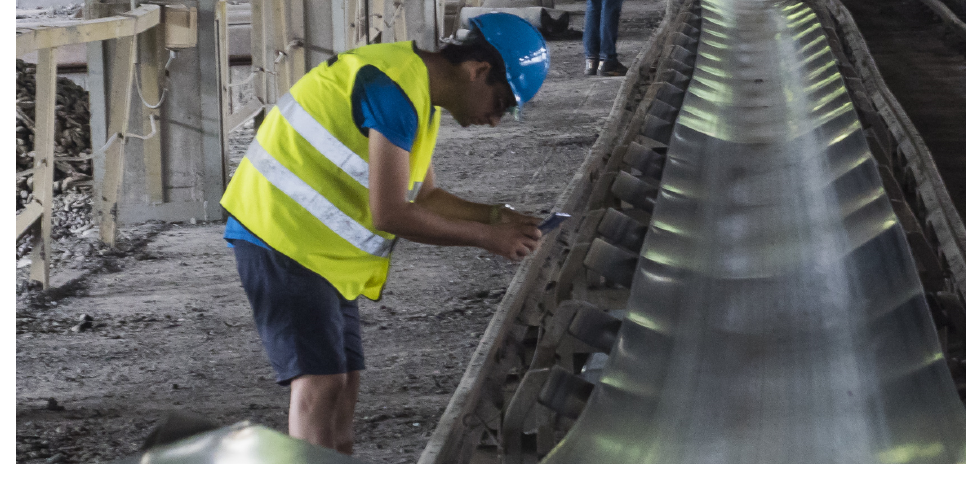
Figure 2. Traditional idler inspection.